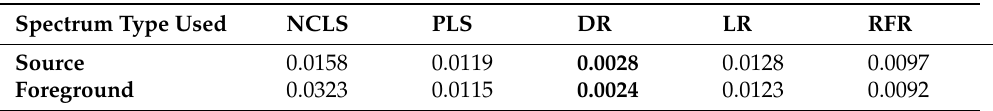
Table 8. Average RMSE values of the test dataset with five methods using Source and Foreground spectra. Bold numbers indicate best performing